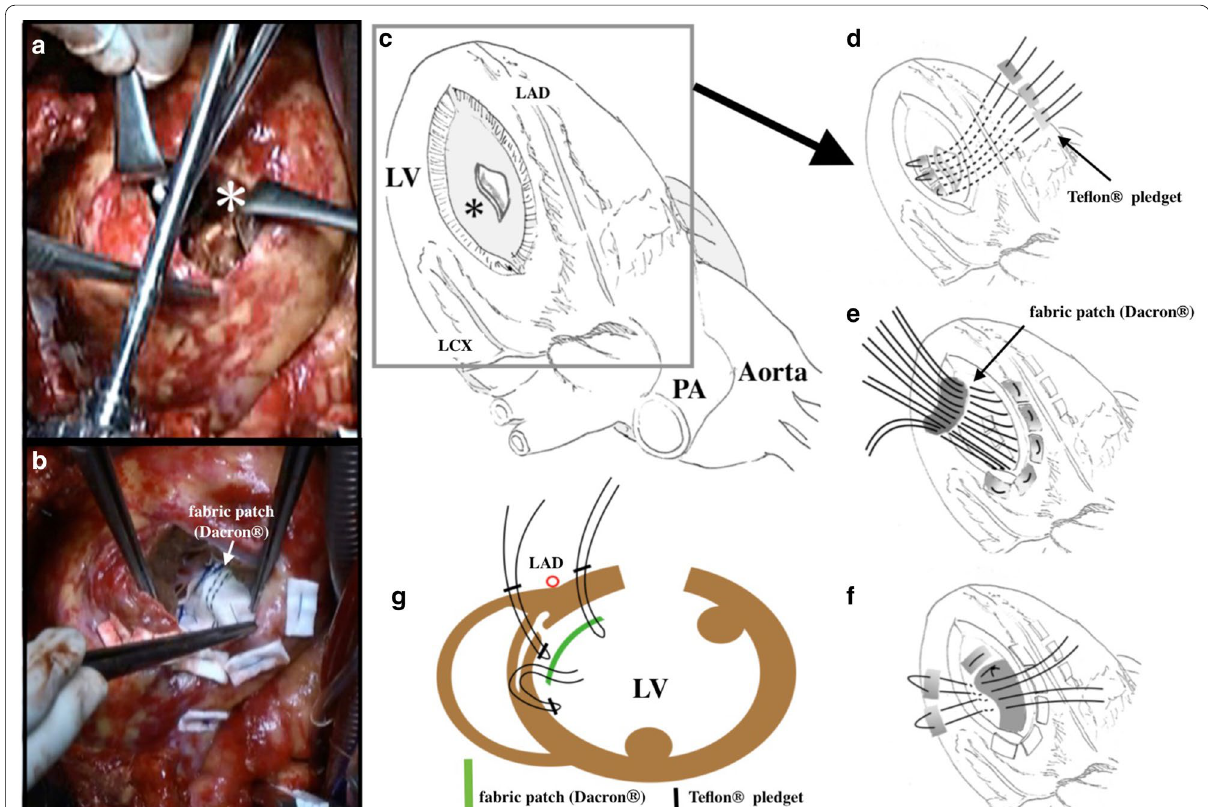
Fig. 3 a Left ventriculotomy showing a small orifice at the ventricular septum. From this orifice, a septal dissecting aneurysm was formed. b Obliteration of the septal dissection. The left ventricle patch was placed over the infarcted septal wall including tear and sutured with pledget 3-0 polypropylene. c The orifice of the septal dissection was located at the middle part of the ventricular septum. d A large suture was passed through the right ventricle from the septum using 3-0 polypropylene with Teflon felt. e , f A fabric oval patch was seated down on the ventricular septum and sutured with pledget 3-0 polypropylene. g A schematic picture of the surgical procedure. The green bar indicates the fabric patch. The small black bars indicate the Teflon pledgets. ( ) indicates the orifice of the septal dissection. LV left ventricle, LAD left ascending coronary artery, LCX left ∗ circumflex coronary artery, PA pulmonary